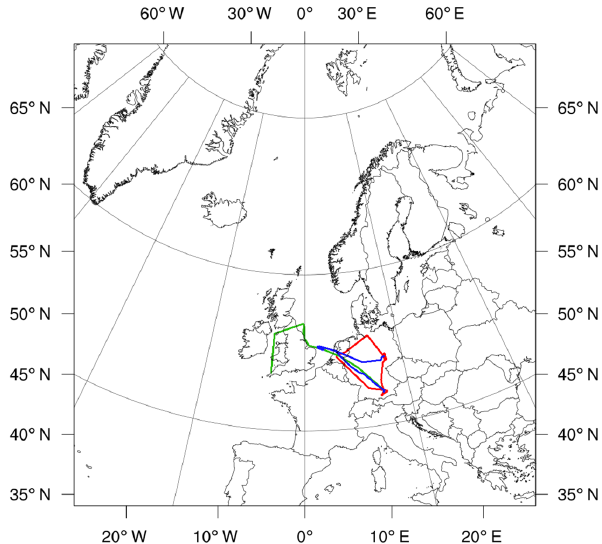
Figure 1. WRF-Chem model domain used for simulations in Lam- bert conformal projection with true latitude and longitude and center at 50 ◦ N, 0 ◦ E/W. Location of Eyjafjallajökull (63.62 ◦ N, 19.61 ◦ W) marked with red dot. DLR Falcon flight paths for flights on 19 April (red), 16 May (green), and 17 May (blue) are shown with colored